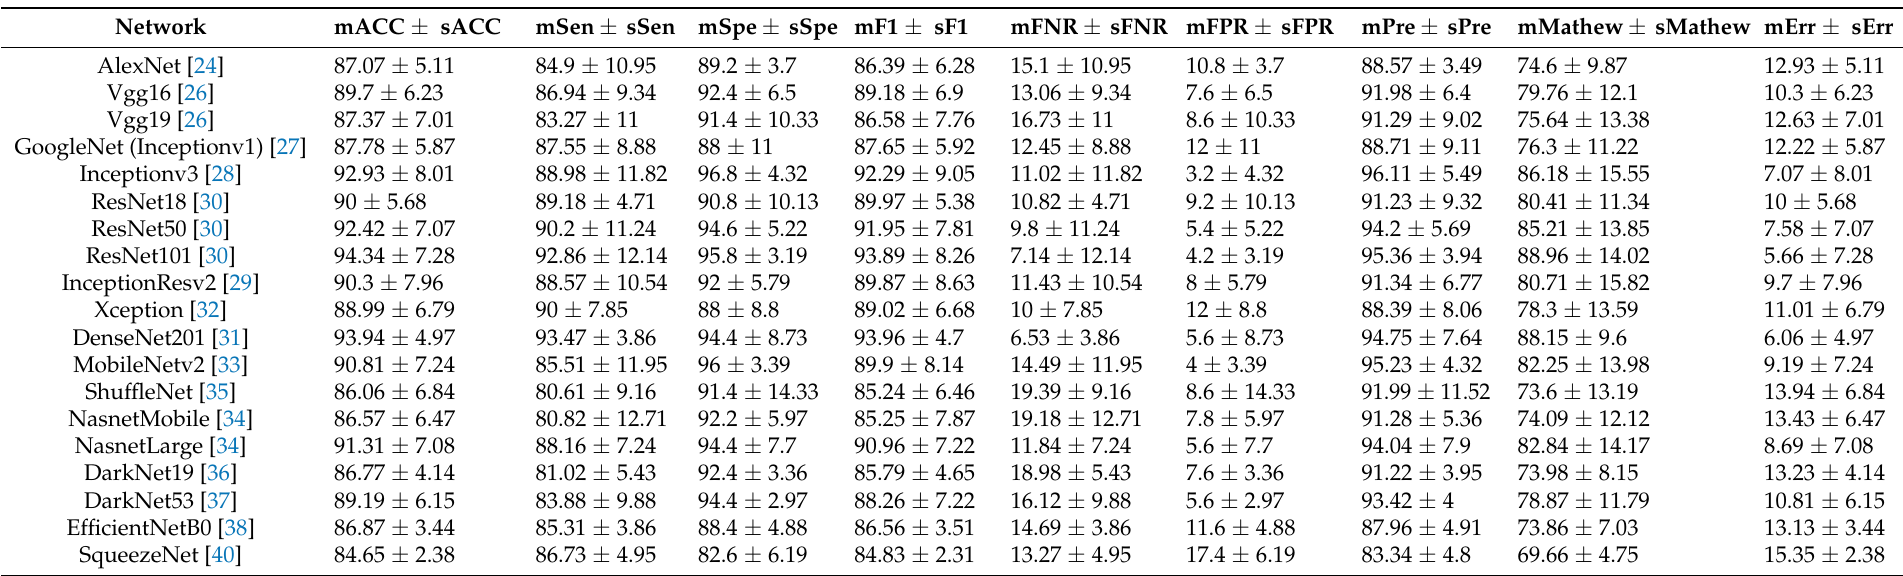
Table 2. The evaluation performance of the 19 CNN models describing the mean value (m) ± standard deviation (s) of a specific criterion over the five folds.